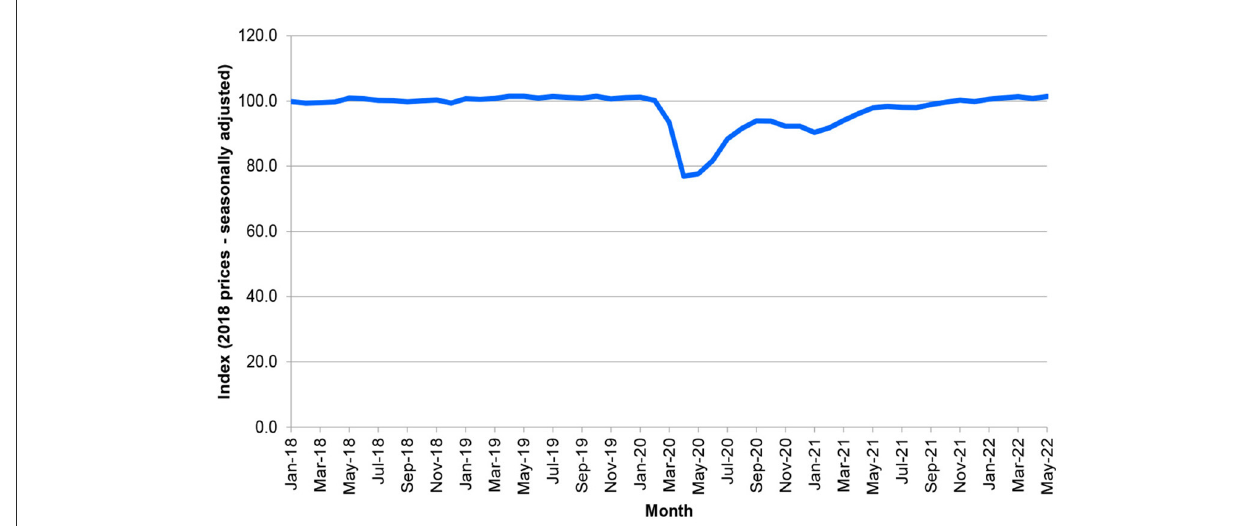
FIGURE1 Scotland—monthly evolution of the gross domestic product. Source: Scottish Government.